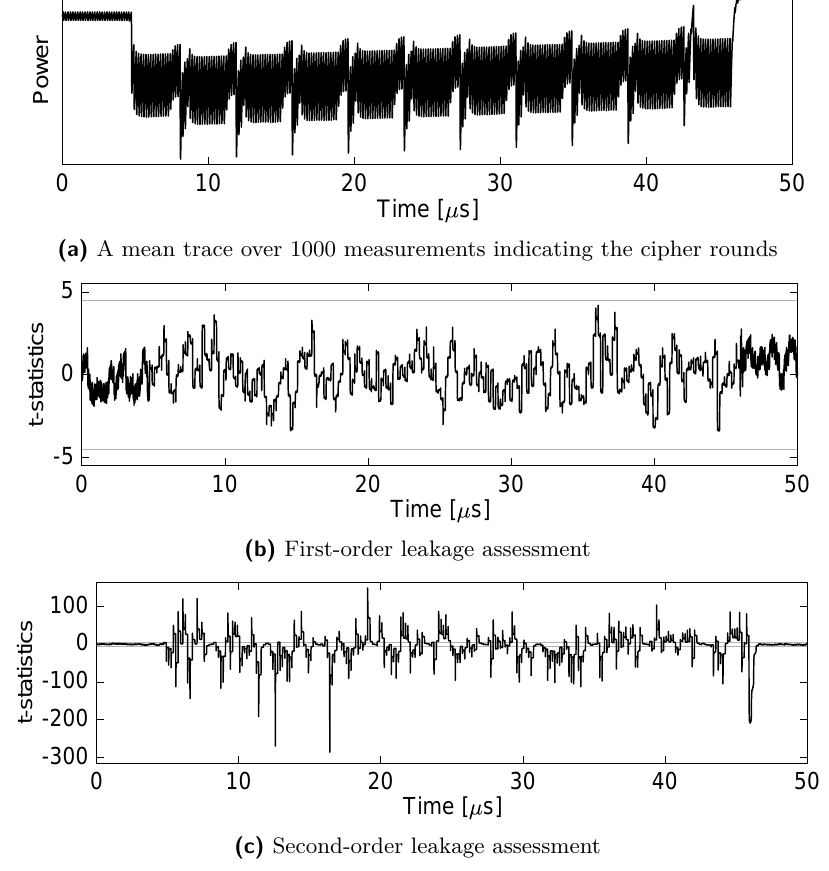
Figure 5: Experimental analysis of our first-order AES byte-serial encryption design (covering the entire encryption); fixed vs. random t-test results using 100 million